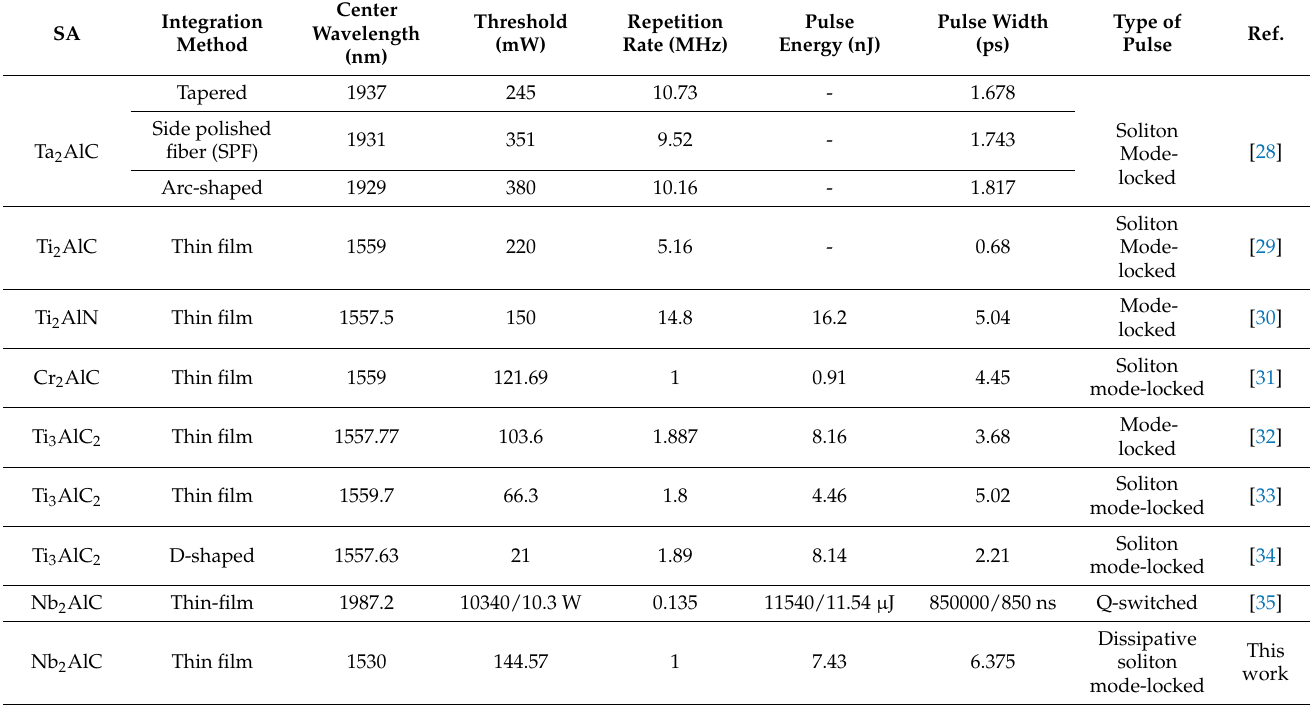
Table 1. Overview of SA based on MAX phase materials on EDF